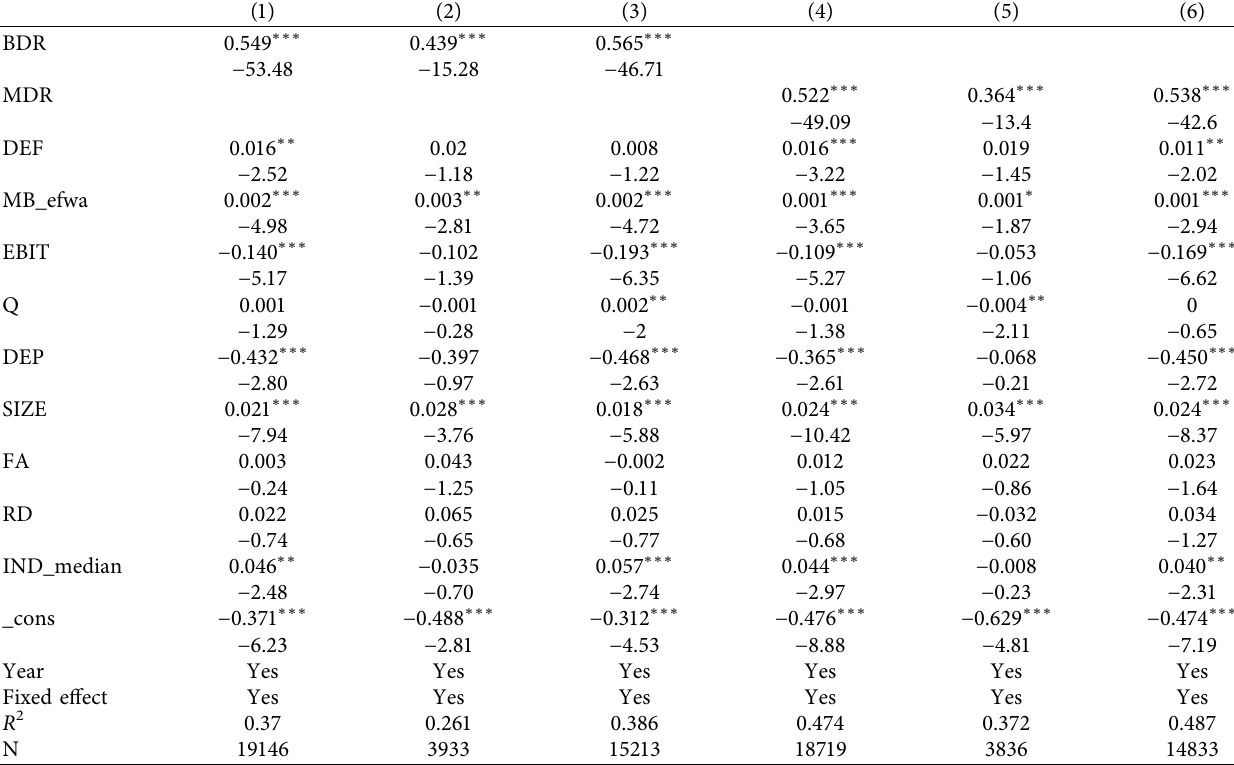
Table 3: Dividend distribution, financing strategies, and the adjustment of capital